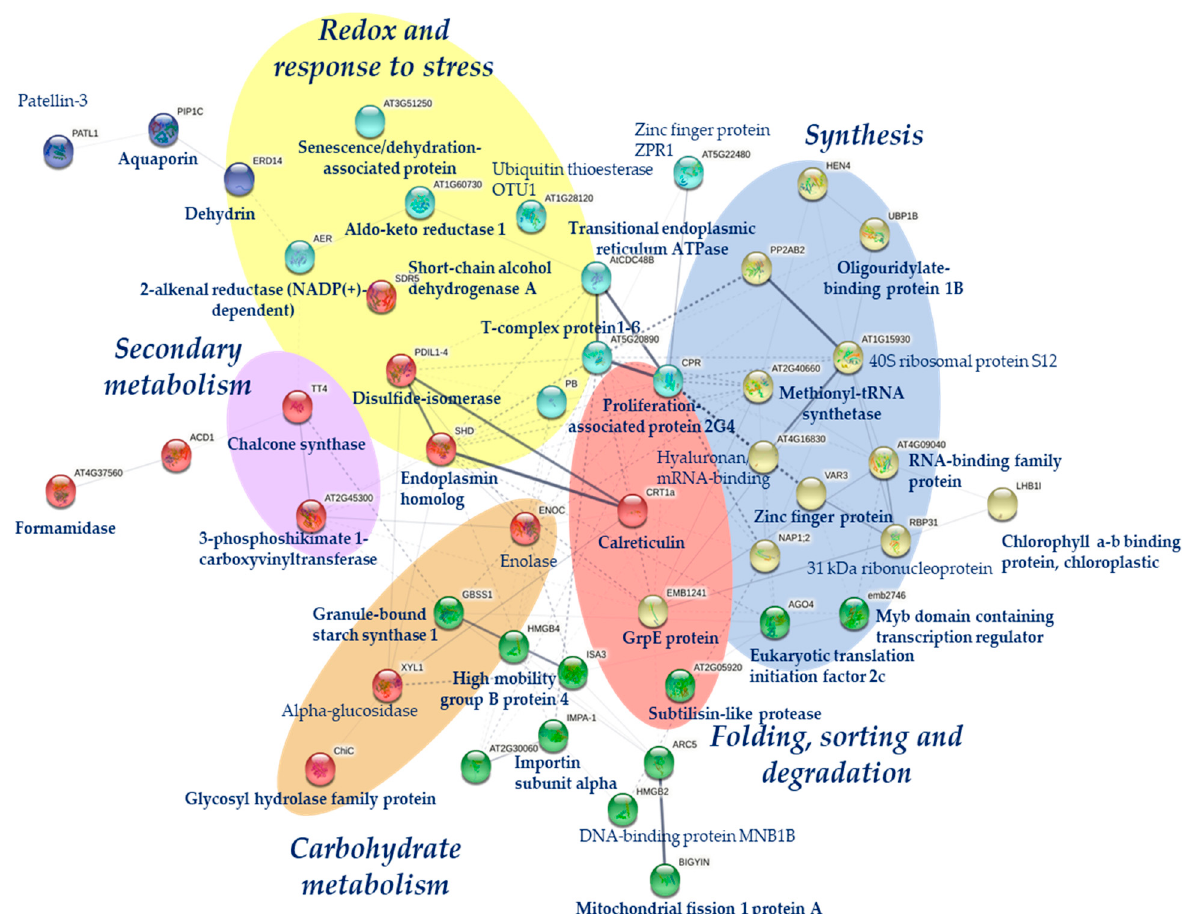
Figure 5. Analysis of the protein interaction network of the 48 proteins selected as putative markers of drought toler- ance.